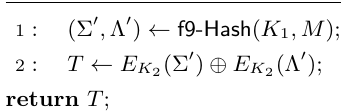
Figure 6.2: Algorithm for 2K-ECBC_Plus 2Kf9